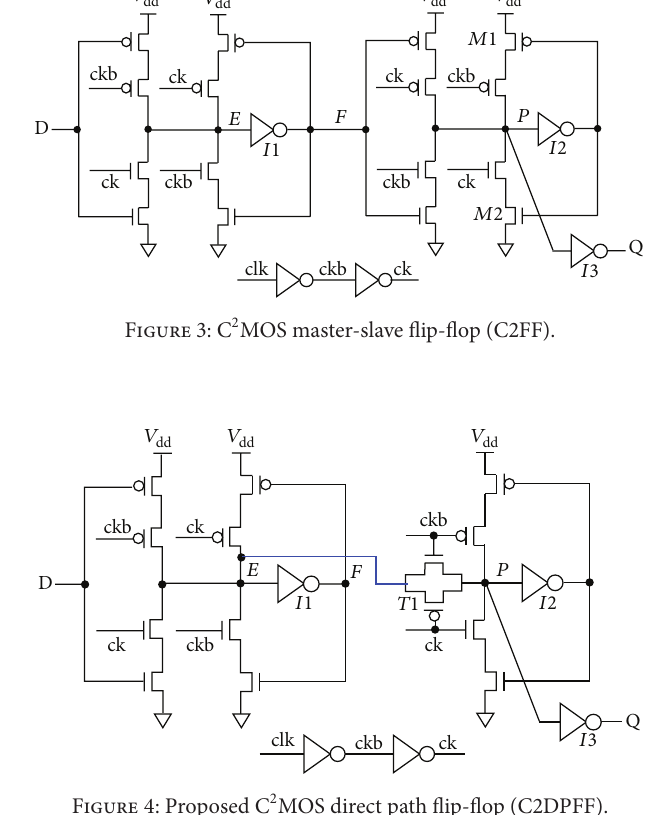
Figure 4: Proposed C 2 MOS direct path flip-flop (C2DPFF).